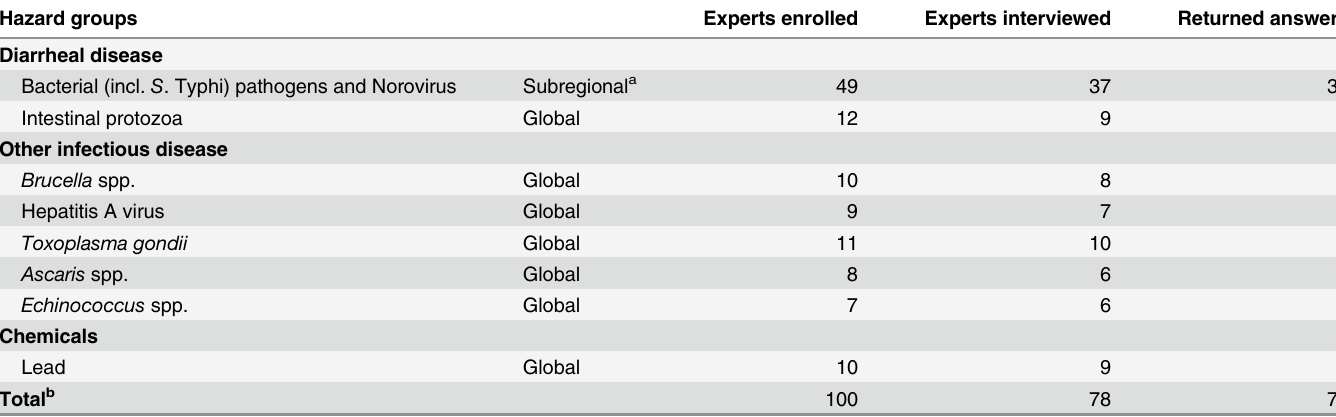
Table 4. The number of experts enrolled, interviewed and finally included in the elicitation across